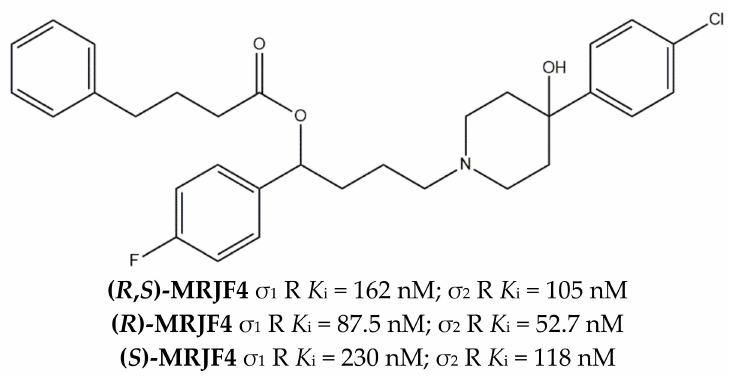
Figure 16. (R,S)-MRJF4 structure and K i values for σ 1 receptor ( σ 1 R) and σ 2 receptor ( σ 2 R)